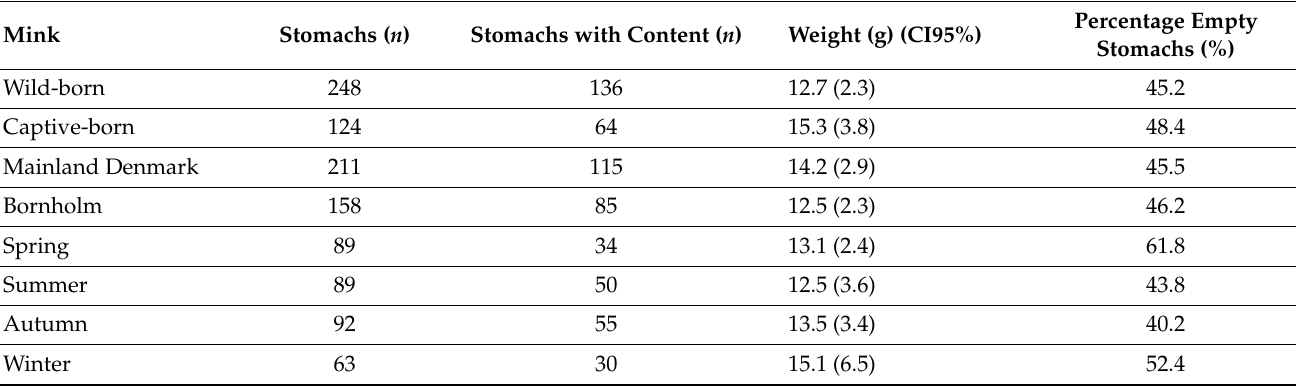
Table 1. Number of stomachs and percentage of empty stomachs in relation to wild-born, captive- born, regions (mainland Denmark and Bornholm), and seasons (spring, summer, autumn and winter), the weight of the stomachs with